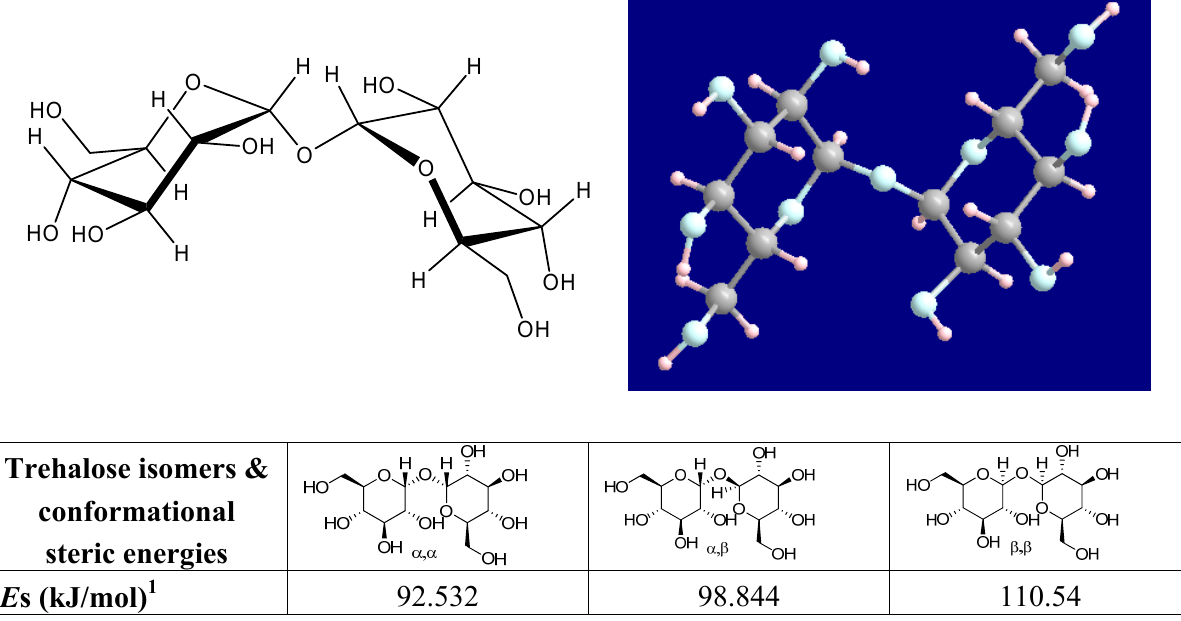
Figure 1. Structure of α,α -trehalose with molecular modeling of trehalose optimized by MOPAC PM3 calculation; and an assessment of the conformational steric energies of all possible trehalose isomers.